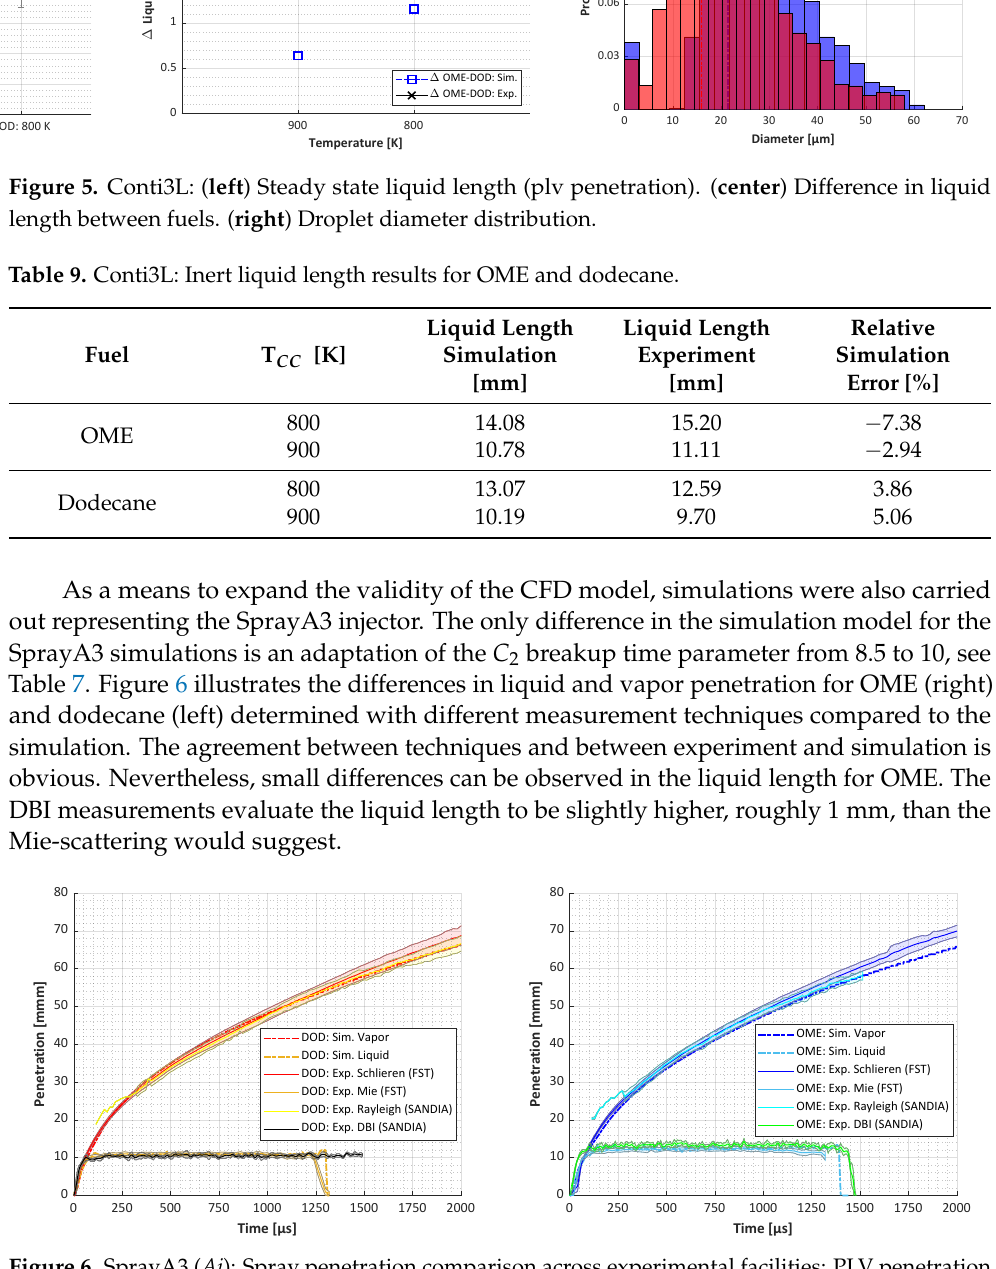
Figure 6. SprayA3 ( Ai ): Spray penetration comparison across experimental facilities: PLV penetration vs Mie (FST) and DBI (Sandia). Vapor penetration vs schlieren (FST) and Rayleigh (Sandia) diagnostics. ( left ) Dodecane. ( right )